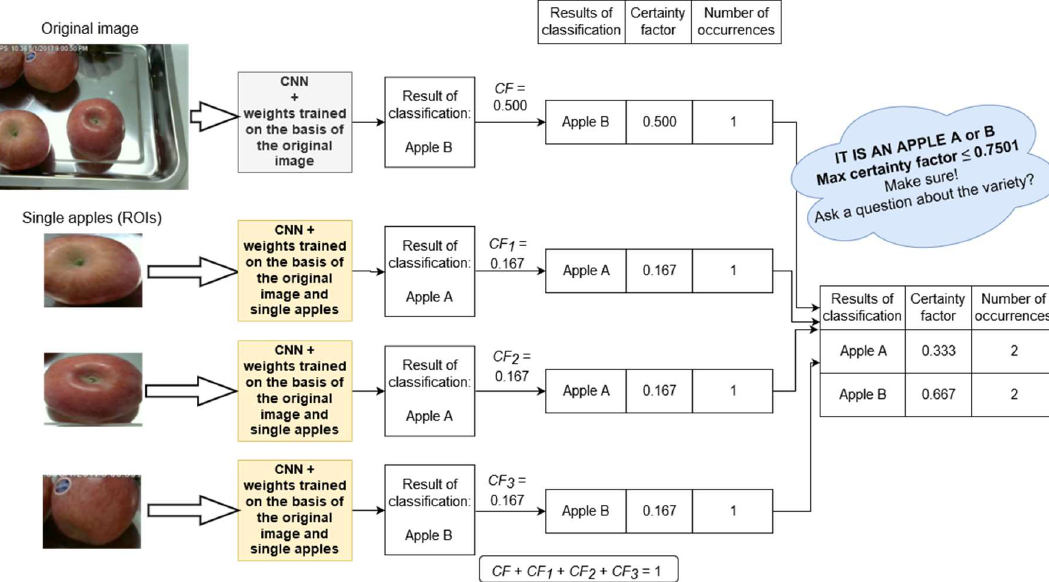
Figure 4. An example of classification using the proposed method: ambiguous classification (based on the original image and ROI images).